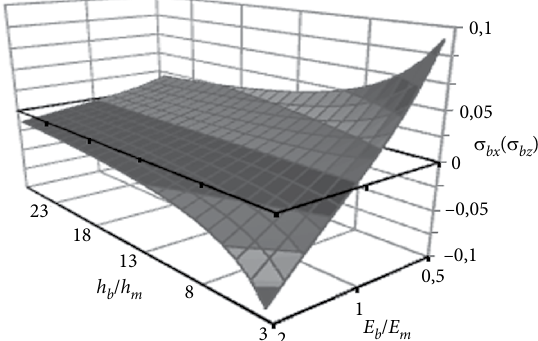
Fig. 3. The relationship of horizontal stress s range of elastic modulus E